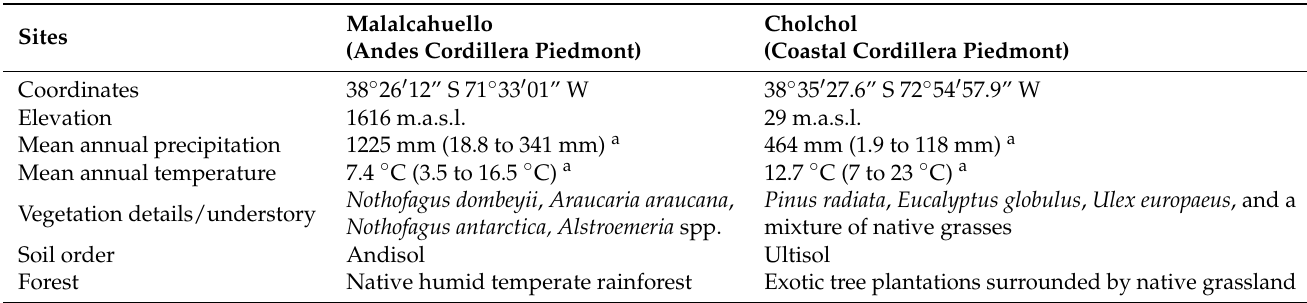
Table 1. Location and general description of the sampling